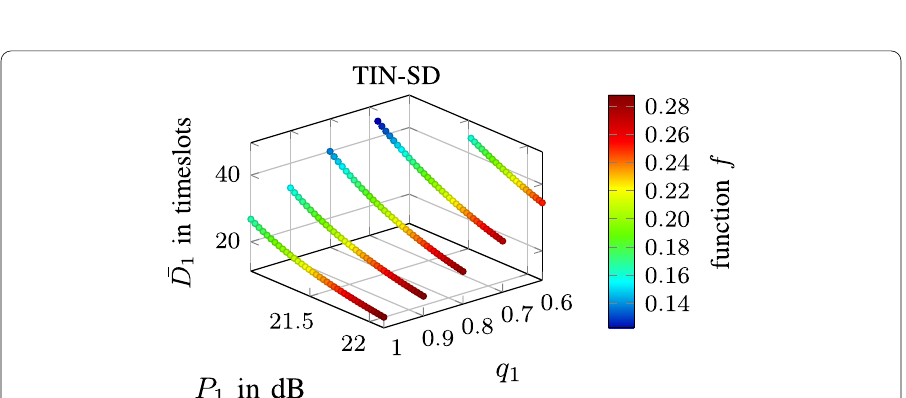
Fig. 5 ( ¯ D 1 , function f aw ) versus ( q 1 , P 1 ), under congestion-aware randomized policy in TIN-SD. The rest of the parameters are the following: (cid:31) 1 = 0.1 , γ 1 = − 4.2dB , γ 2 = − 6.4dB , α = 2.2 , β = 41dB , P J = 23dB , q 2 = 0.4 , B = 6 packets, P max = 23dB , d 2 = 14.6m , and d 12 = 10m . In TIN-SD, d 1 = 17.4m